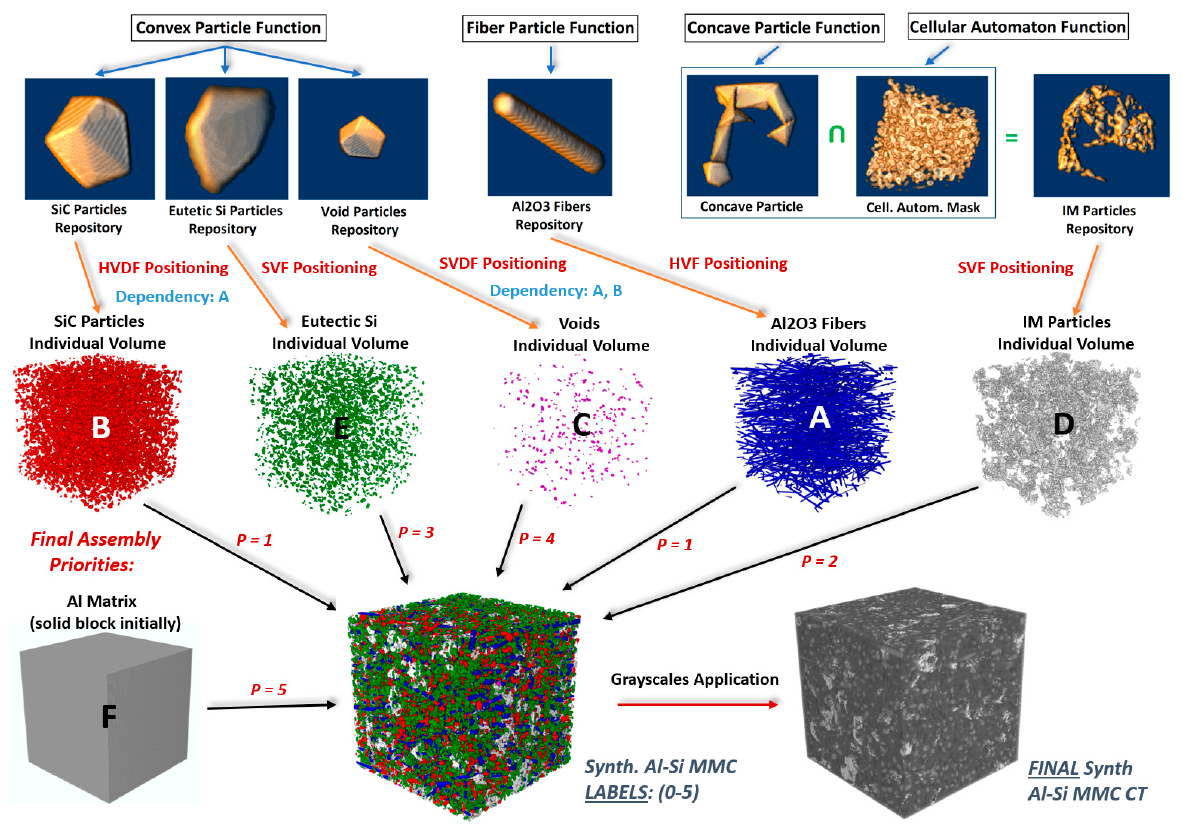
Figure 3. Synthetic Al–Si MMC generation procedure flowchart.